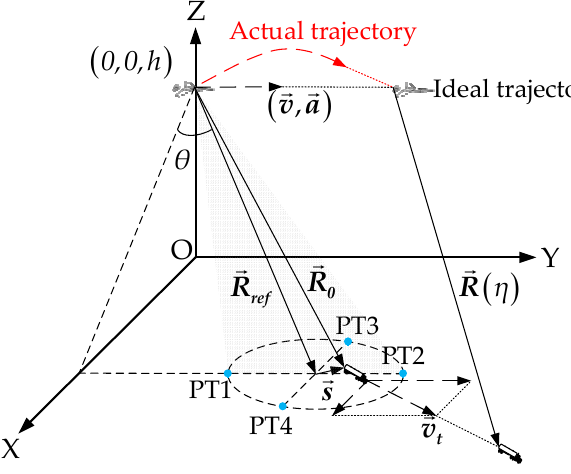
Figure 1. Geometrical model of a squint-looking NS-HSV-SAR and moving target.